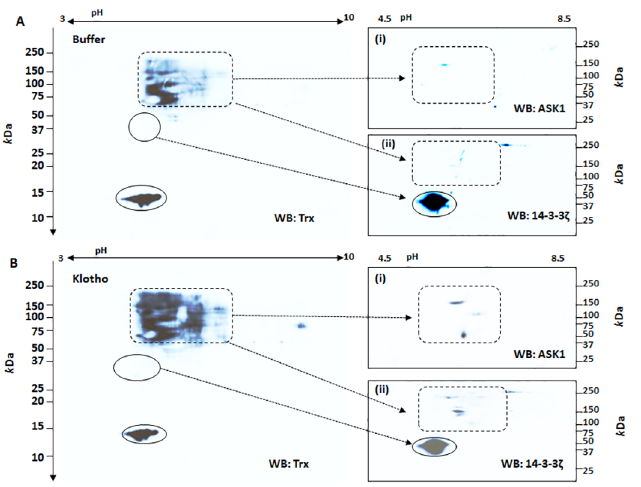
Fig 6. Non-reducing 2D-GE Western blot analyses of ASK1 signaling complex in HEK 293 cells. A non- reducing 2D-GE that preserves endogenous disulfide linkage was performed on Klotho-treated and buffer- control cells as described in the text. Images in A (buffer treated) or B (Klotho treated) are representative Western blots probed with either Trx antibody or stripped and re-probed with (i) ASK1 and/or (ii) 14-3-3 ζ . Closed circled spots indicate free Trx and/or 14-3-3 ζ proteins based on p I and/or molecular size. The dotted rectangular spots represent ASK1-bound complexes with Trx and/or 14-3-3 ζ and other proteins cross- reactive with the Trx antibody that were more abundant in Klotho treated cells than in the buffer